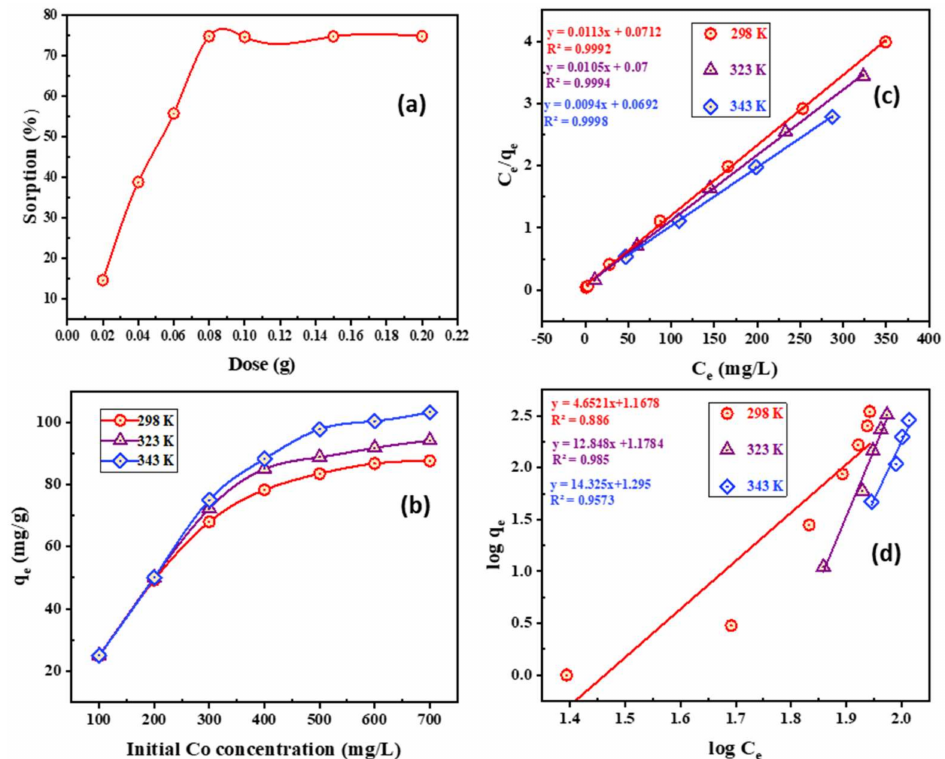
Figure 7. ( a ) Impact of PTU-MSA dose upon Co 2+ adsorption (20 mL of 250 mg/L Co 2+ , pH 8.0, 20 min, 25 ◦ C); ( b ) Impact of initial Co 2+ concentration upon PTU-MSA uptake (20 mL of 250 mg/L Co 2+ , pH 8.0, 20 min, 0.08 g PTU-MAS); ( c ) Langmuir isotherm model; ( d ) Freundlich isotherm mode